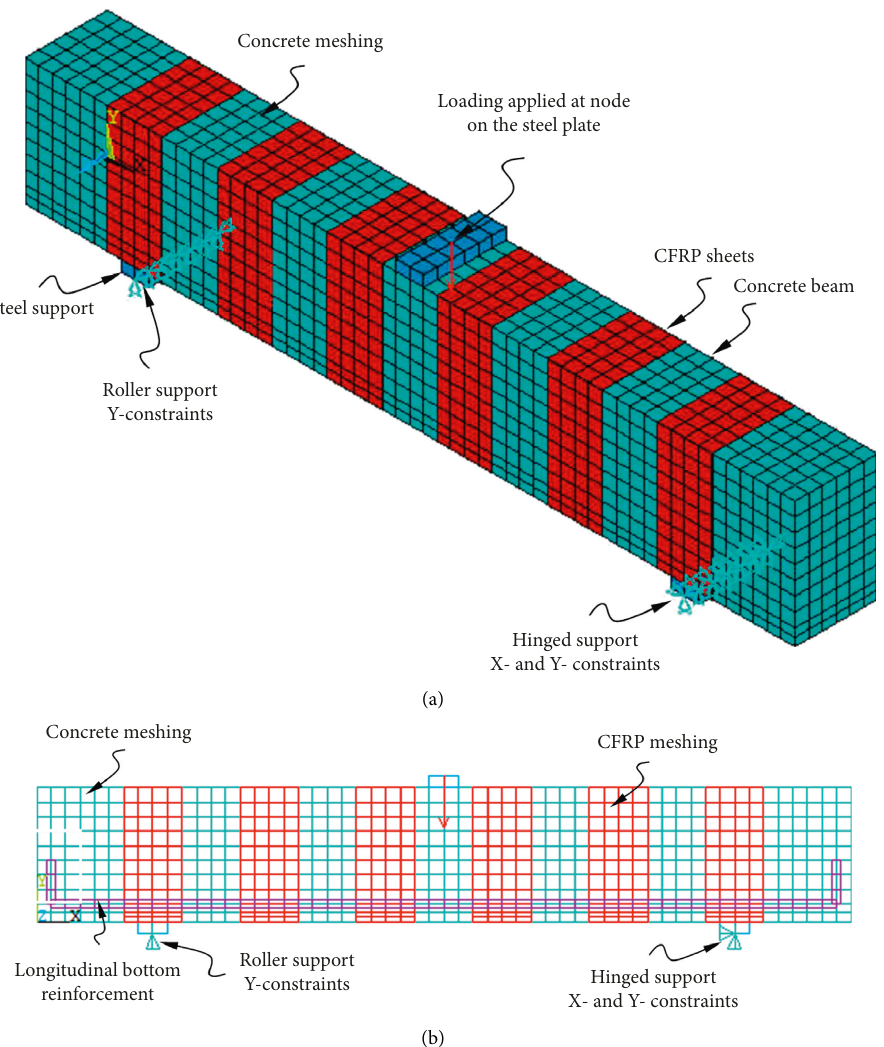
Figure 2: 3D finite element model of beam A2.5RC10/10: (a) meshing, loads, and boundary conditions; (b) position of longitudinal bottom reinforcement.